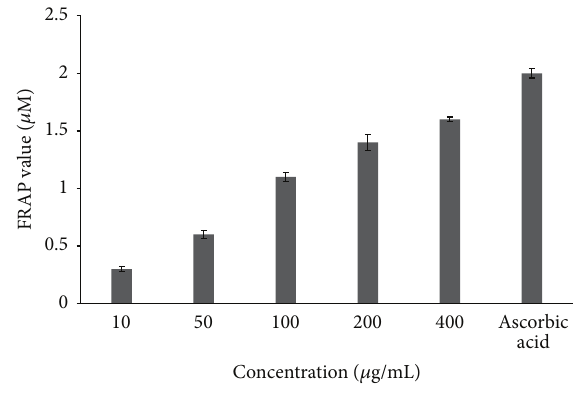
Figure 3: In vitro antioxidant activity of M. oppositifolius extract using the FRAP